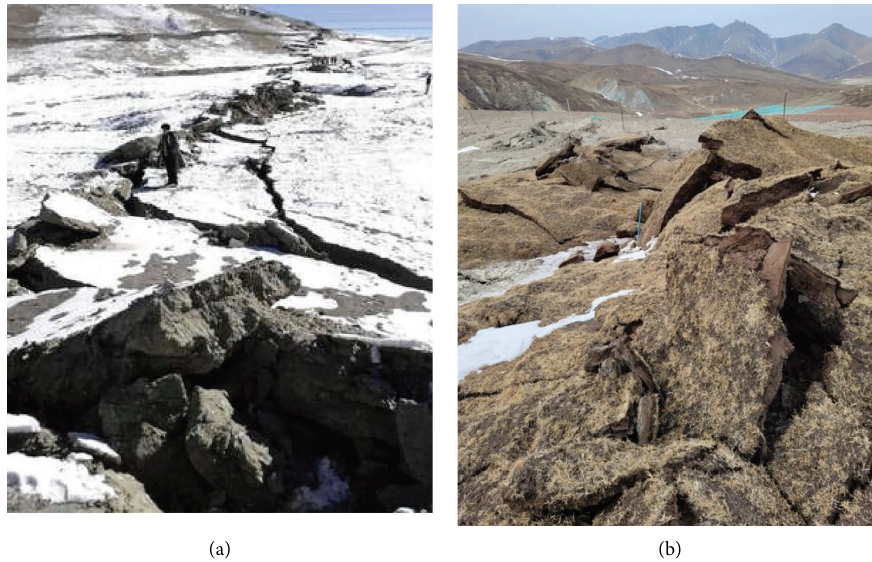
Figure 1: Surface rupture zone in permafrost area caused by earthquakes: (a) Kunlunshan earthquake; (b) Menyuan earthquake.